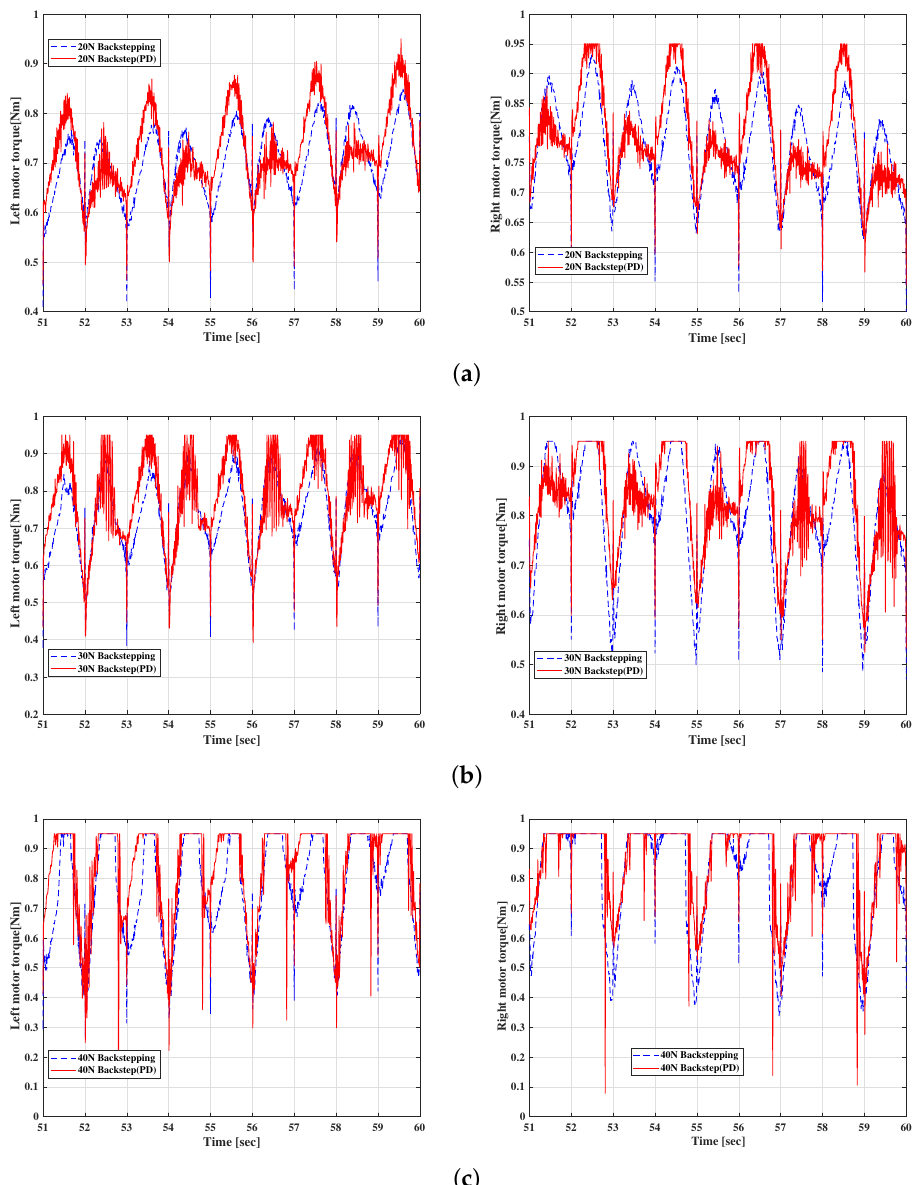
Figure 7. Results of the motor torque with variable brush interaction force. ( a ) Force = 20 N; ( b ) Force = 30 N; ( c ) Force = 40